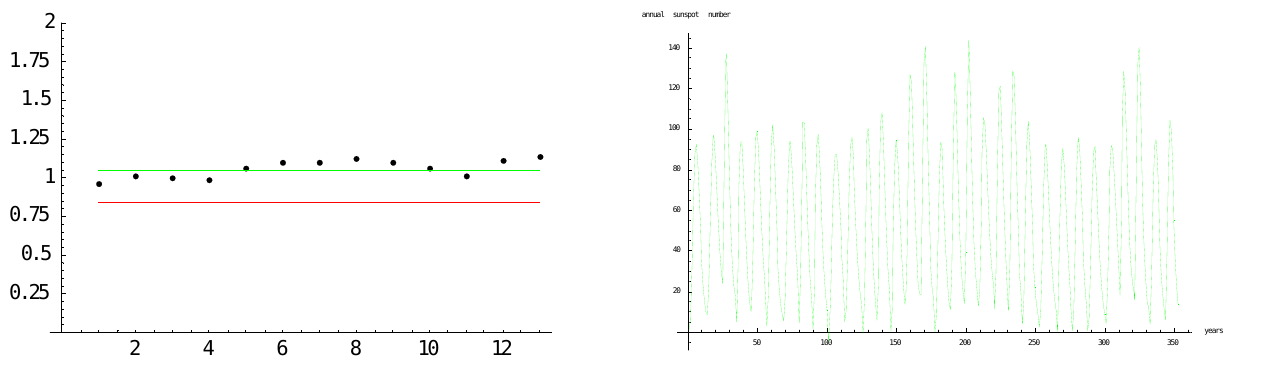
Fig. 16. Regression values (black points) γ 24 versus order p , their average (green line) in comparison with the “nonlinear” (cid:1) = 0 . 8354 (red line). The value obtained from the γ 24 = ϕ (cid:0) γ ∗ 23 nonlinear analysis is systematically lower than autoregression es- timates.